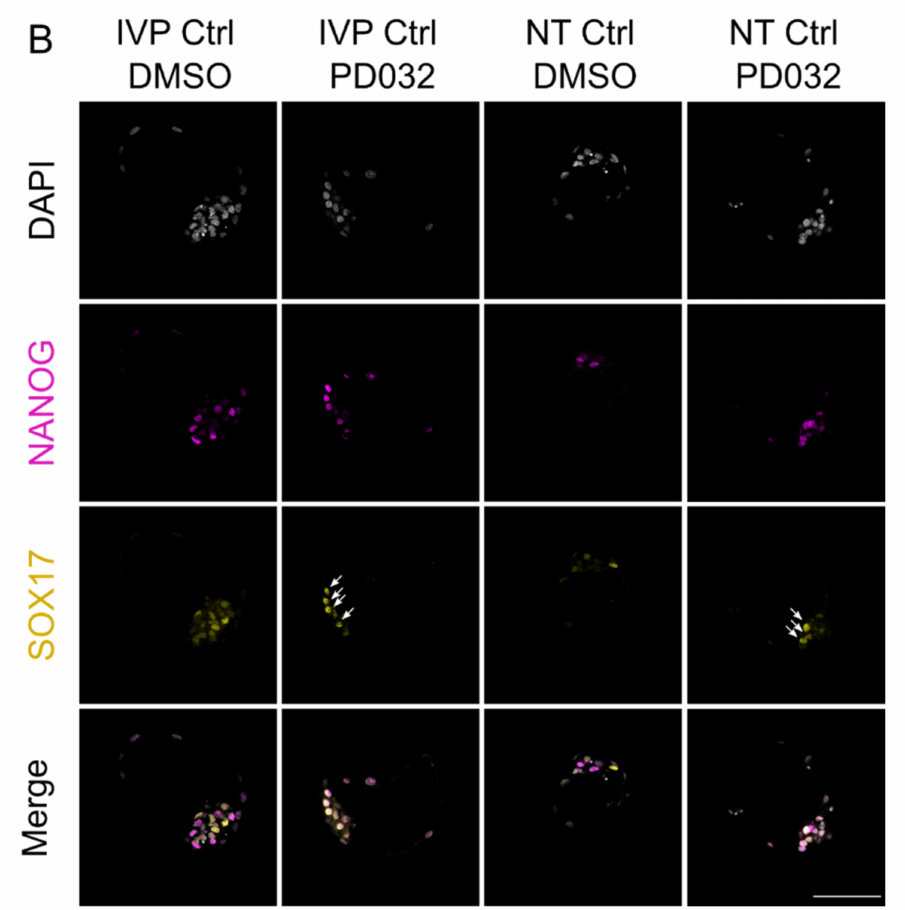
Figure 2. The effect of different dosages of MEK-inhibitor PD0325901 (PD032) on the expression of NANOG, GATA6, and SOX17. ( A ) The ratio of ICM/Total, NANOG/ICM, and GATA6/ICM in the presence of 0.5 and 2.5 µ M PD032 in IVP Ctrl embryos. The proportion of ICM to total cell number (Total) is shown, and the number of NANOG and GATA6 expressing cells was set in relation to the number of ICM cells. Embryos were cultured from day 5 morula to day 8 blastocyst in the presence of 0.5 and 2.5 µ M PD032. Data were analyzed by Kruskal–Wallis with Dunn’s multiple comparisons test as post hoc test and are presented as mean ± standard deviation. Different superscripts (a, b) indicate significant differences between groups ( p < 0.0001), n.s. = not significant. Sample sizes of ICM/Total and NANOG/ICM were n = 49, 30, 19 and of GATA6/ICM n = 40, 30, 7 for DMSO (grey), 0.5 µ M (red) and 2.5 µ M (blue) PD032, respectively. ( B ) Representative confocal planes of NANOG and SOX17 expression in IVP Ctrl and NT Ctrl blastocysts cultured with DMSO or 2.5 µ M PD032. Sample sizes of embryos stained for NANOG (magenta) and SOX17 (yellow) were n = 49 for IVP Ctrl DMSO, n = 19 for IVP Ctrl PD032, n = 8 for NT Ctrl DMSO, and n = 9 for NT Ctrl PD032. DAPI = grey; arrows indicate SOX17 expression in the presence of 2.5 µ M PD032; scale bar indicates 100 µ